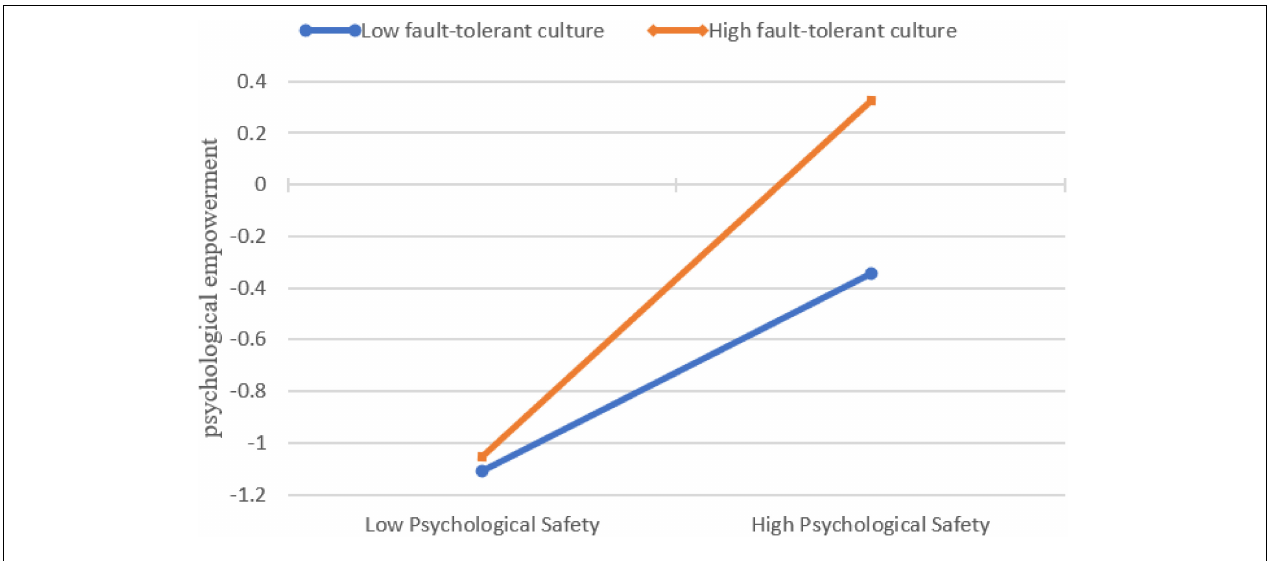
FIGURE 2 | Simple slope analysis.